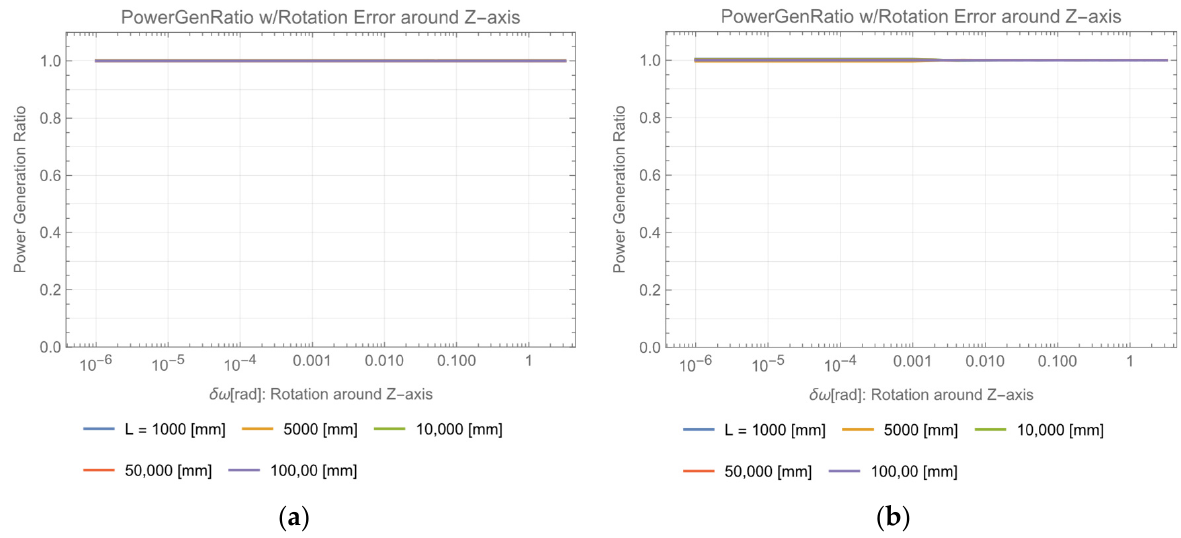
Figure 12. Power Generation Ratio Dependence on Rotation around Optical Axis: ( a ) Focus Opti- mized at Each L; ( b ) Focus Optimized at 100 m.